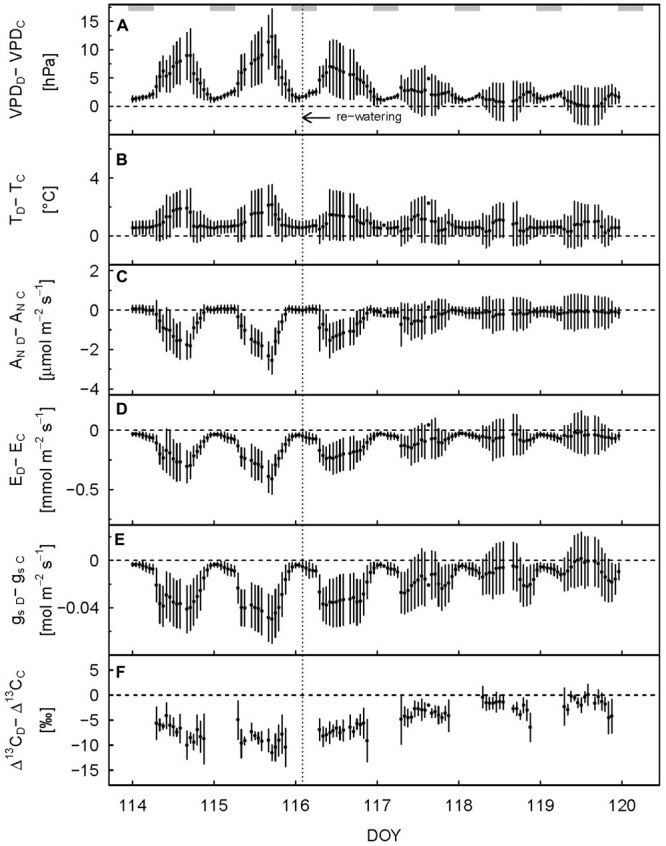
Hourly difference in vapor pressure deficit (A), air temperature (B), net assimilation (C), transpiration (D), stomatal conductance to H2O (E), and observed photosynthetic carbon isotope discrimination (F) between drought-treated (subscript D) and control (subscript C) saplings 2 days before and 4 days after re-watering. Shaded rectangles at the top indicate nighttime. Re-watering is represented by the dashed vertical line. Error bars show error propagated standard deviation, data are only shown when at least two replicates were available.